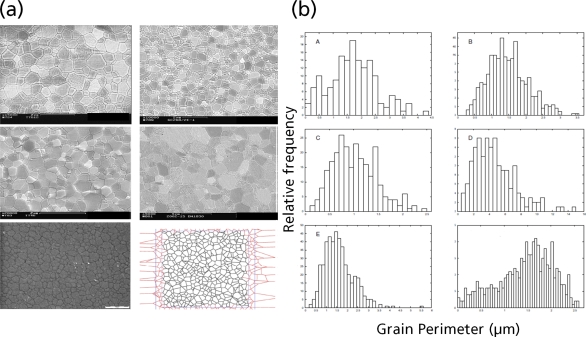
5 different Al2O3 micrographs (a) and their corresponding grain statistics with respect to the grains’ perimeter (b). The right picture at the bottom of (a) and (b) exhibits a corresponding 2D virtual cut through the 3D PD, i.e., a Voronoi diagram, and its corresponding histogram. Clearly, the histograms both show no Gaussian distribution as was claimed, e.g., by Zhang et al. [167].